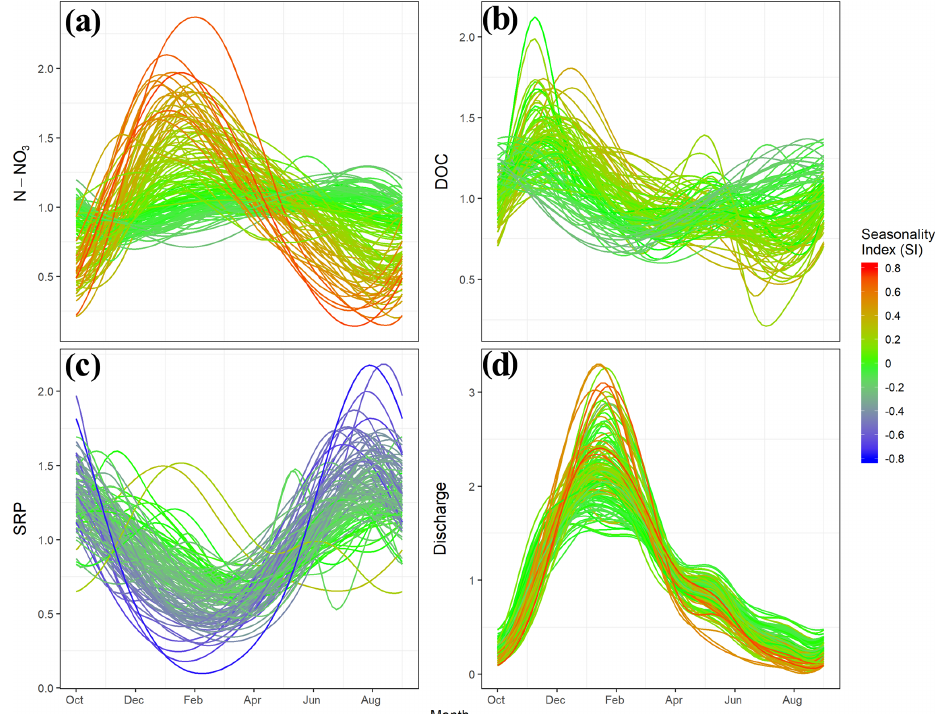
Figure 5. Seasonal dynamics of (a) nitrate N (N-NO 3 ), (b) dissolved organic carbon (DOC), (c) soluble reactive phosphorus (SRP), and (d) daily discharge modelled by generalized additive models, for 185 headwater catchments. To compare concentrations, they are standard- ized by their mean interannual concentration. The colour gradient represents the seasonality index of each parameter; thus, a headwater catchment’s colour can vary among